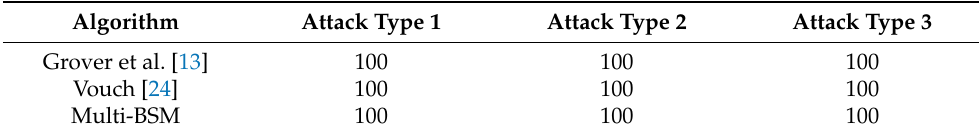
Table 4. Comparison of accuracy rate in low vehicle density.